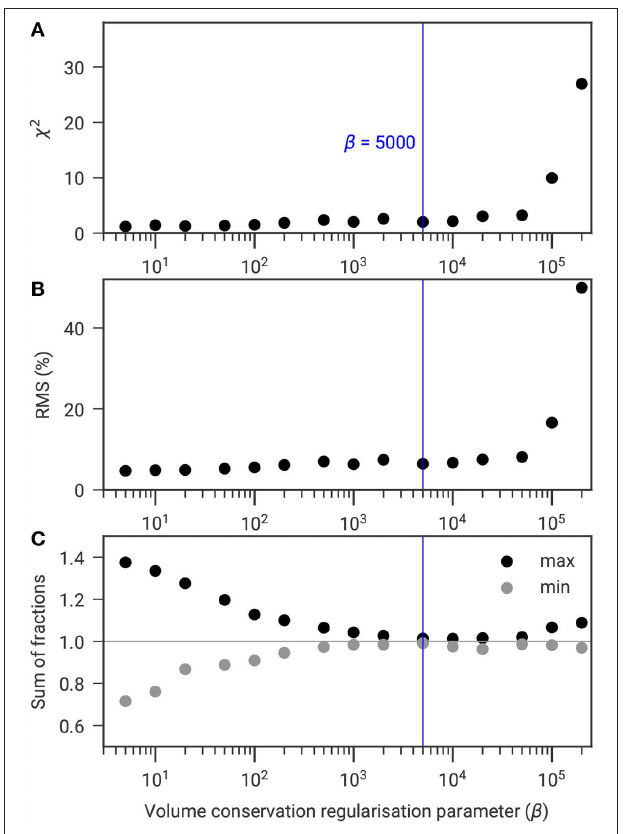
FIGURE 7 | Scatter plot of the vertical anisotropic smoothness parameter zWeight against (A) χ 2 , (B) RMS, and (C) minimum and maximum sum of the four fractions to determine the most adequate value of zWeight for the Cervinia field site (for constant α and β ).